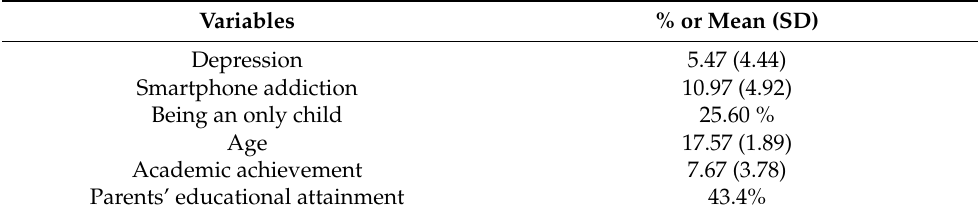
Table 1. Descriptive Statistics.